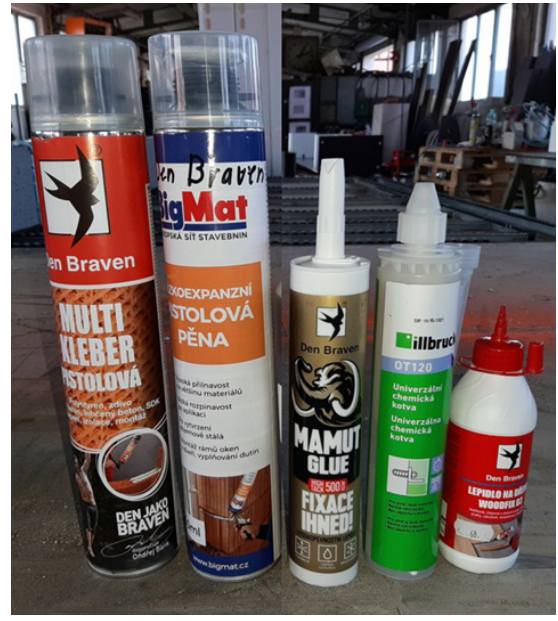
Figure 3. The selected adhesives: F – MULTI